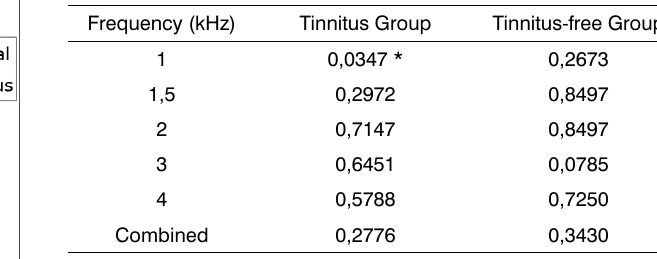
Chart 1. Descriptive levels (p-values) from the comparison of sup- pression outcomes per frequency range, separately and combined, between right and left